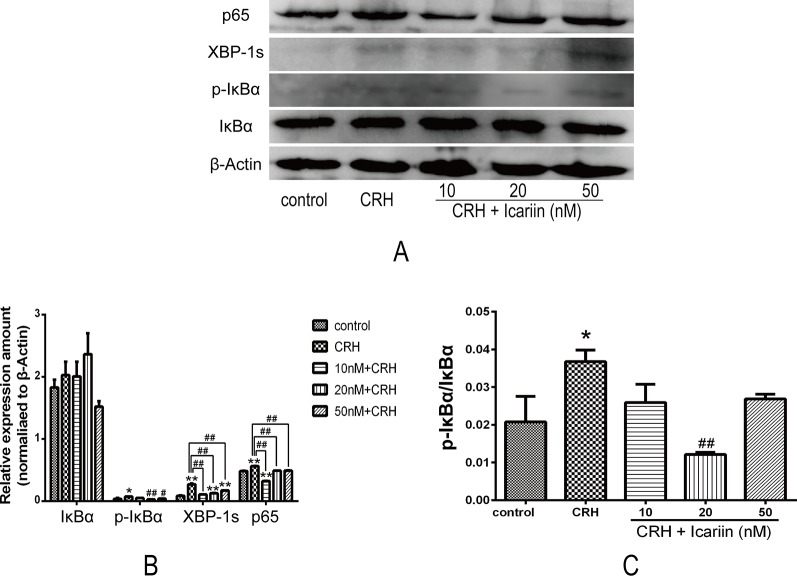
Icariin suppressed expression of XPB-1s and activation of NF-κB pathway in fetal hippocampal neurons. Primary cultured rat hippocampal neurons were pretreated with different concentrations of icariin (10, 20 or 50nM) for 2 h followed by treatment of CRH for 24 h. The immunoblotting (A) and the corresponding histogram (B) of XPB-1s and NF-κB as well as pIκBα/IκBα (C) showed protein expression in different groups. β-actin was reused from Figure 3 in the assessment of XPB-1s and NF-κB pathway.*p < 0.05 and **p < 0.01 vs control; #p < 0.05 and ##p < 0.01 vs CRH.